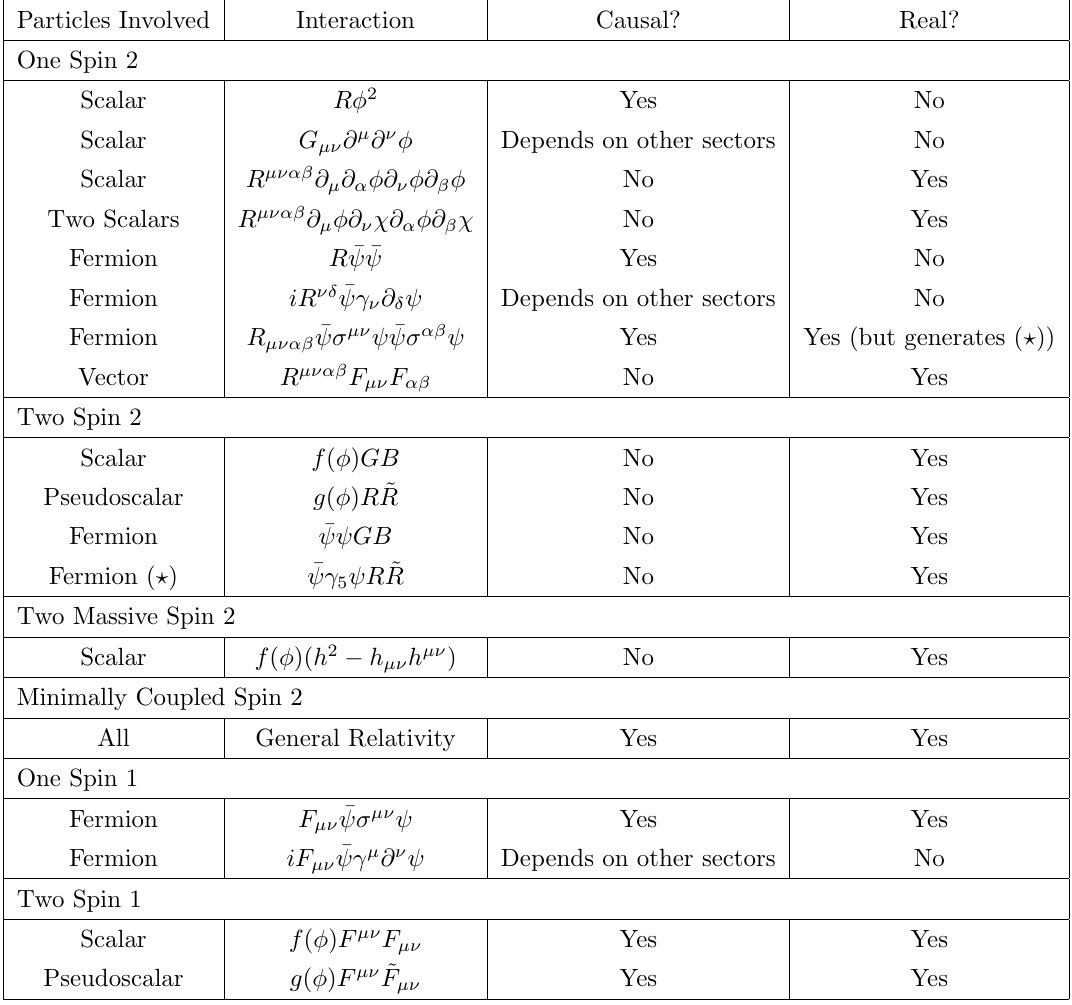
Table 1 . Table of the interactions considered in paper. The columns indicate as follows: (cid:12)rst is the particles involved in the interaction; second is the explicit interaction term; third is if the interaction leads to causality propagation, with the caveat that some depend on other sectors of the theory; fourth is if the interaction produces a non-zero scattering amplitude and hence is